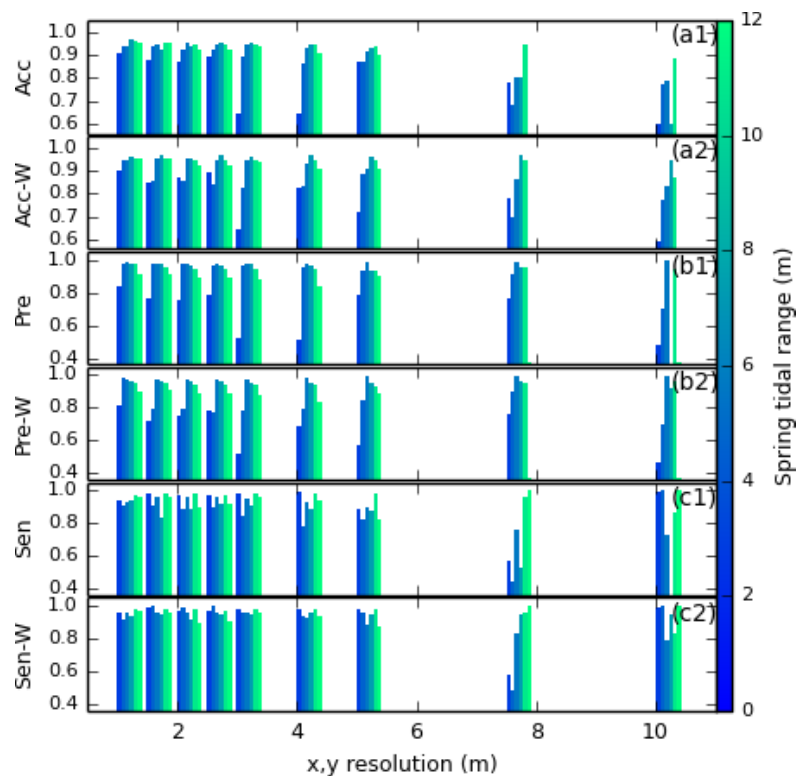
Figure 8. Performance of the platform detection method for all sites, coloured according to their spring tidal range; (a1) accuracy of the method when no filter is used; (a2) accuracy of the method when using a Wiener filter; (b1) precision of the method when no filter is used; (b2) precision of the method when using a Wiener filter; (c1) sensitivity of the method when no filter is used; (c2) sensitivity of the method when using a Wiener